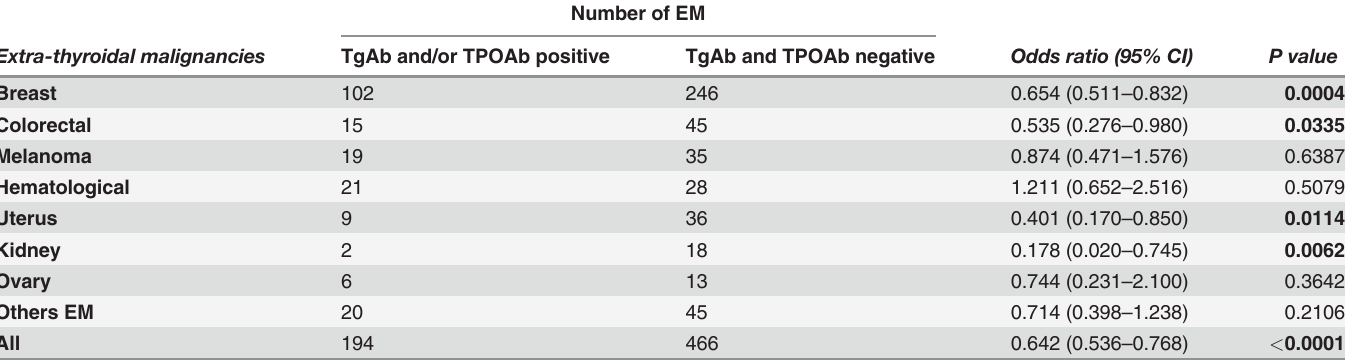
Table 4. Differences in the Prevalence of Extra-Thyroidal Malignancies in Patients Positive (n = 2,369) or Negative (n = 3,820) for TgAb and/or